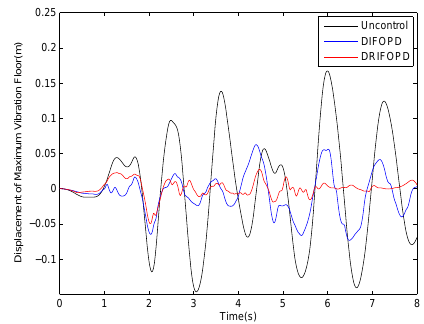
Figure 11. The displacement of the maximum vibration floor under fault case 1.